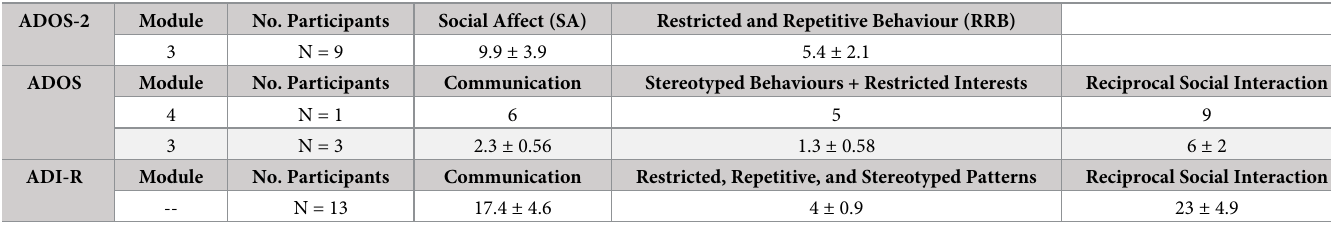
ADOS-2, ADOS, and ADI-R sub-scale values show (mean ± standard deviation). ADOS was not available for two participants (P205 and P212) and ADI-R was not available for two participants (P202 and P210).